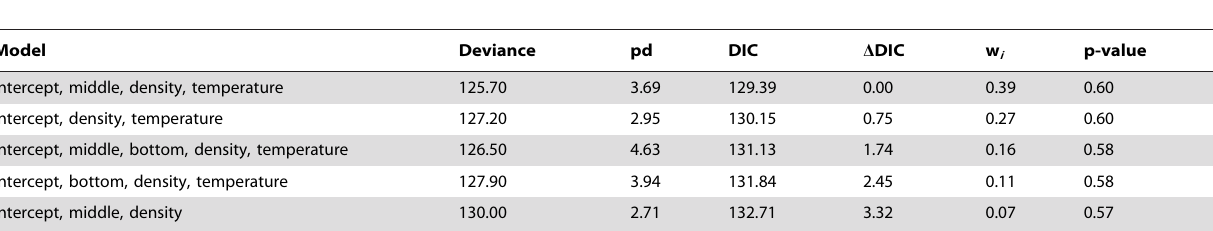
Table 2. Deviance, effective number of parameters (pd), deviance information criterion (DIC), D DIC, DIC weights (w i ), and Bayesian p-values (p-value) for the confidence set of logistic regression models relating African jewelfish eDNA detections to pond- and sample-level factors.